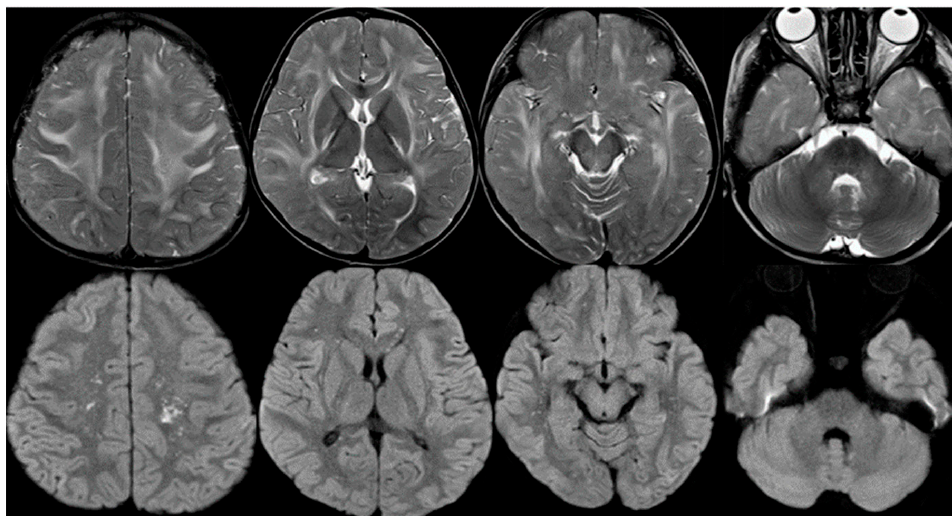
Figure 1. Brain MRI on hospital day 8. T2-weighted images ( upper row) demonstrated extensive vasogenic edema in the bilateral cerebral white matter, genu of the corpus callosum, external capsule, posterior limb of the internal capsule, midbrain, middle cerebellar peduncle, and cerebellar white matter. Diffusion-weighted images ( lower row) showed multiple microinfarctions in the bilateral cerebral white matter.